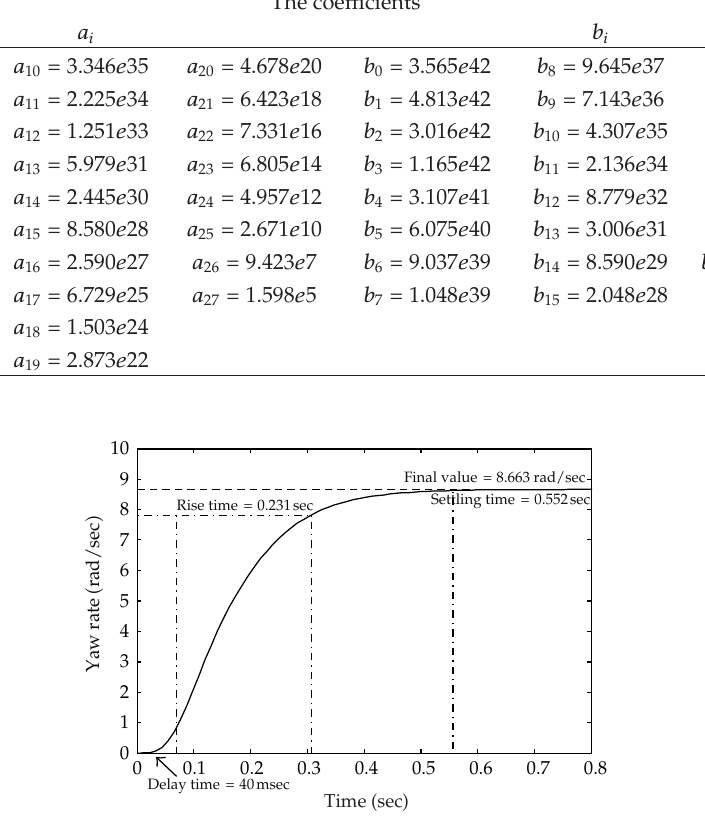
Table 10: The coe ffi cients of the transfer function in (cid:4) 5.3 (cid:5) . The coe ffi cients